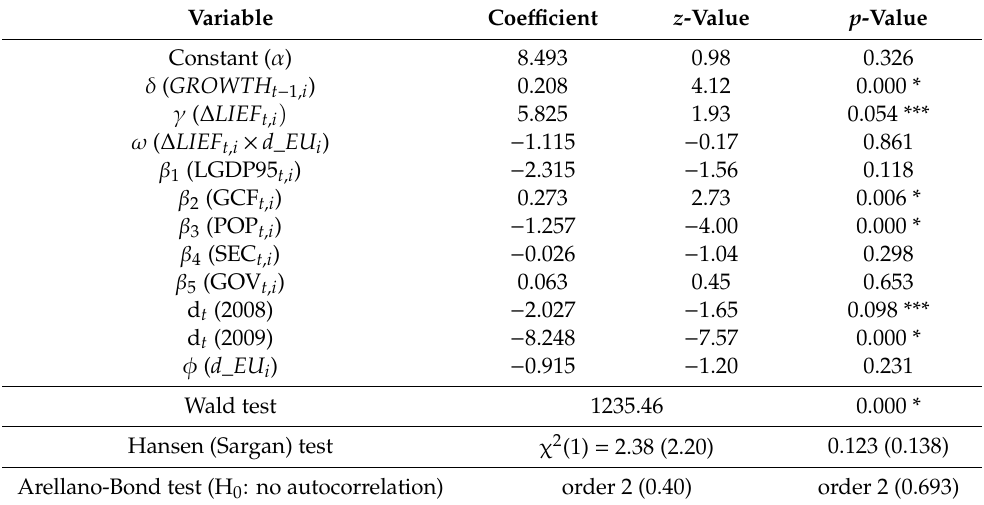
Table 10. Results from the System GMM model with change in log of economic freedom ( ∆